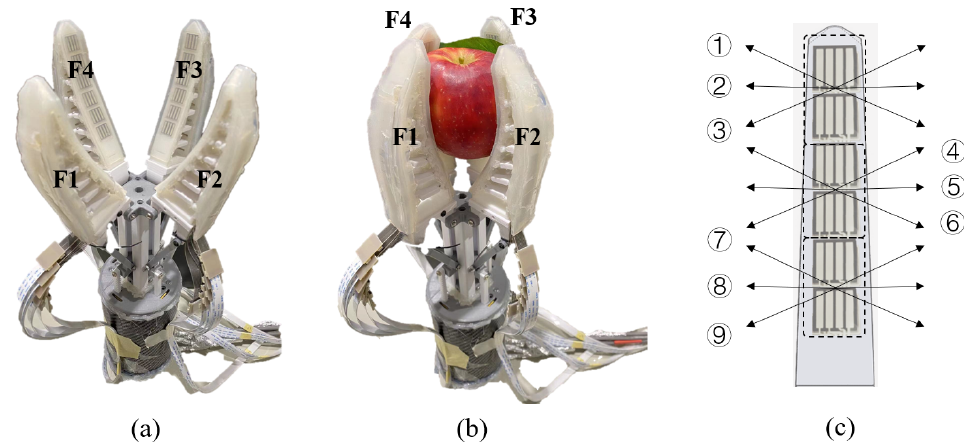
Figure 7. Data collection. ( a ) Gripper open; ( b ) Gripper close; ( c ) Leaf sliding